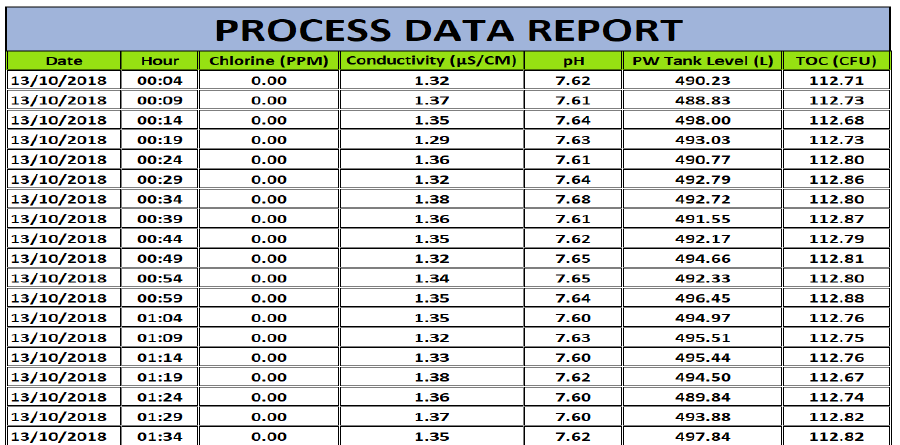
Figure 14. Daily report of the system stored in the SCADA PC.